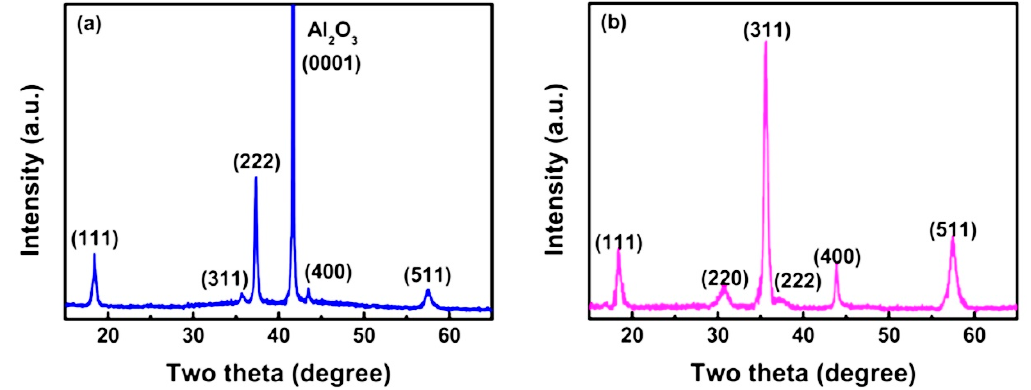
Figure 8. XRD patterns of ZnGa 2 O 4 films grown on: ( a ) sapphire(0001) and ( b ) Si(100) substrates [78].